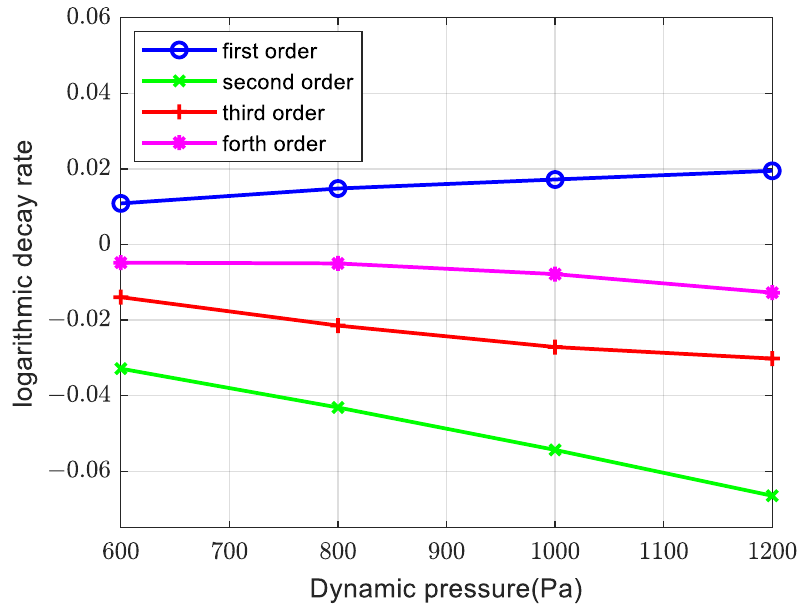
Figure 20. Variations in the logarithmic decay rate of generalized displacement with the dynamic pressure ( Ma = 0.6, α = 90 ◦ ).